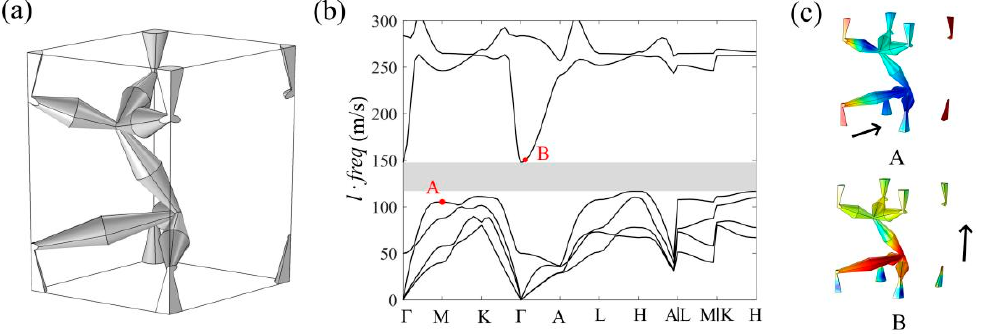
Figure 9. Primitive cell with P 1 moving in horizontal directions: ( a ) primitive cell ( b ) band structures with a band gap in grey ( c ) specific modes.